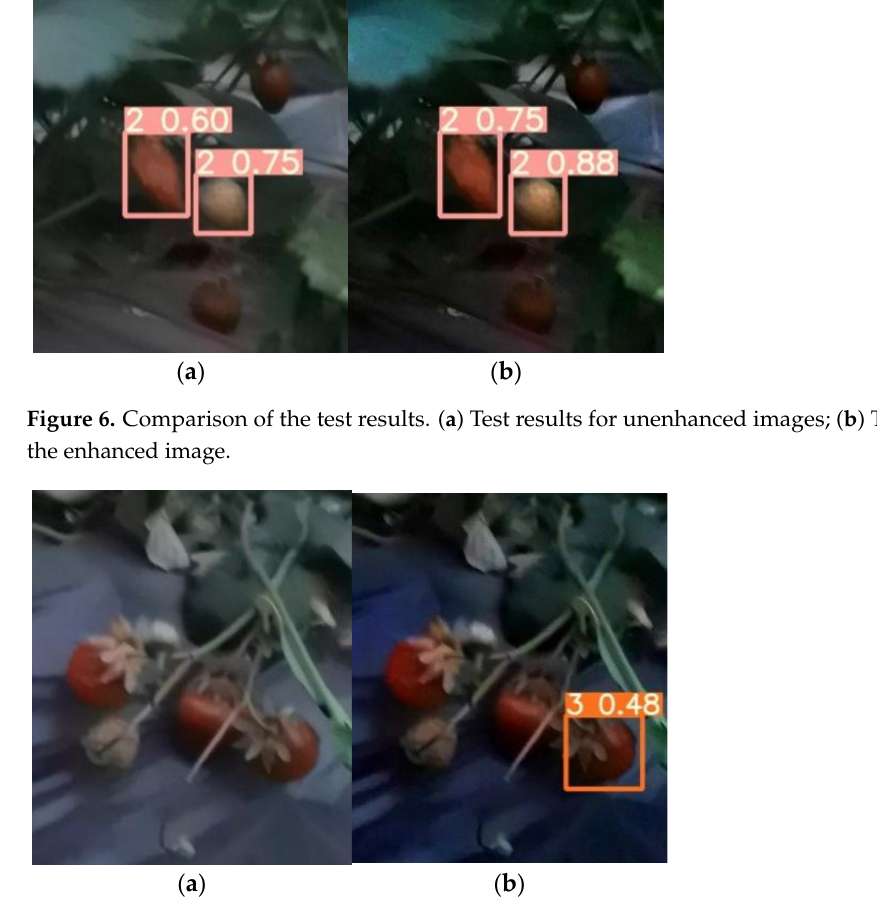
Figure 7. Comparison of test results before and after enhancement. ( a ) Test results for unenhanced images; ( b ) Test results of the enhanced image.